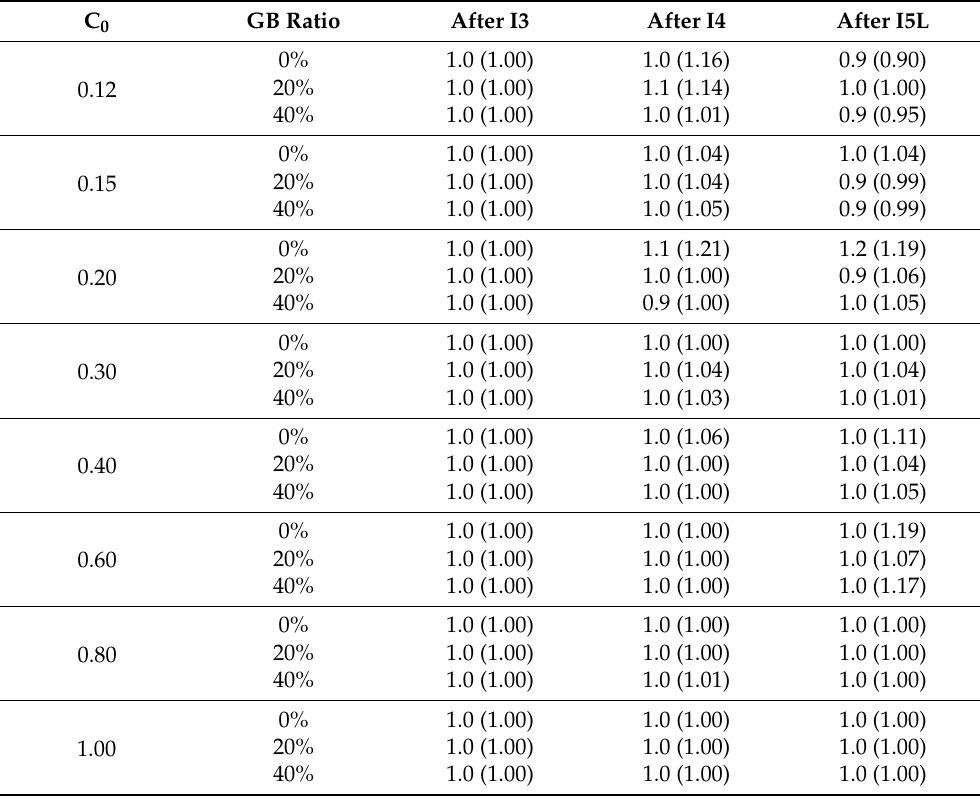
Table 7. Magnifications of maximum